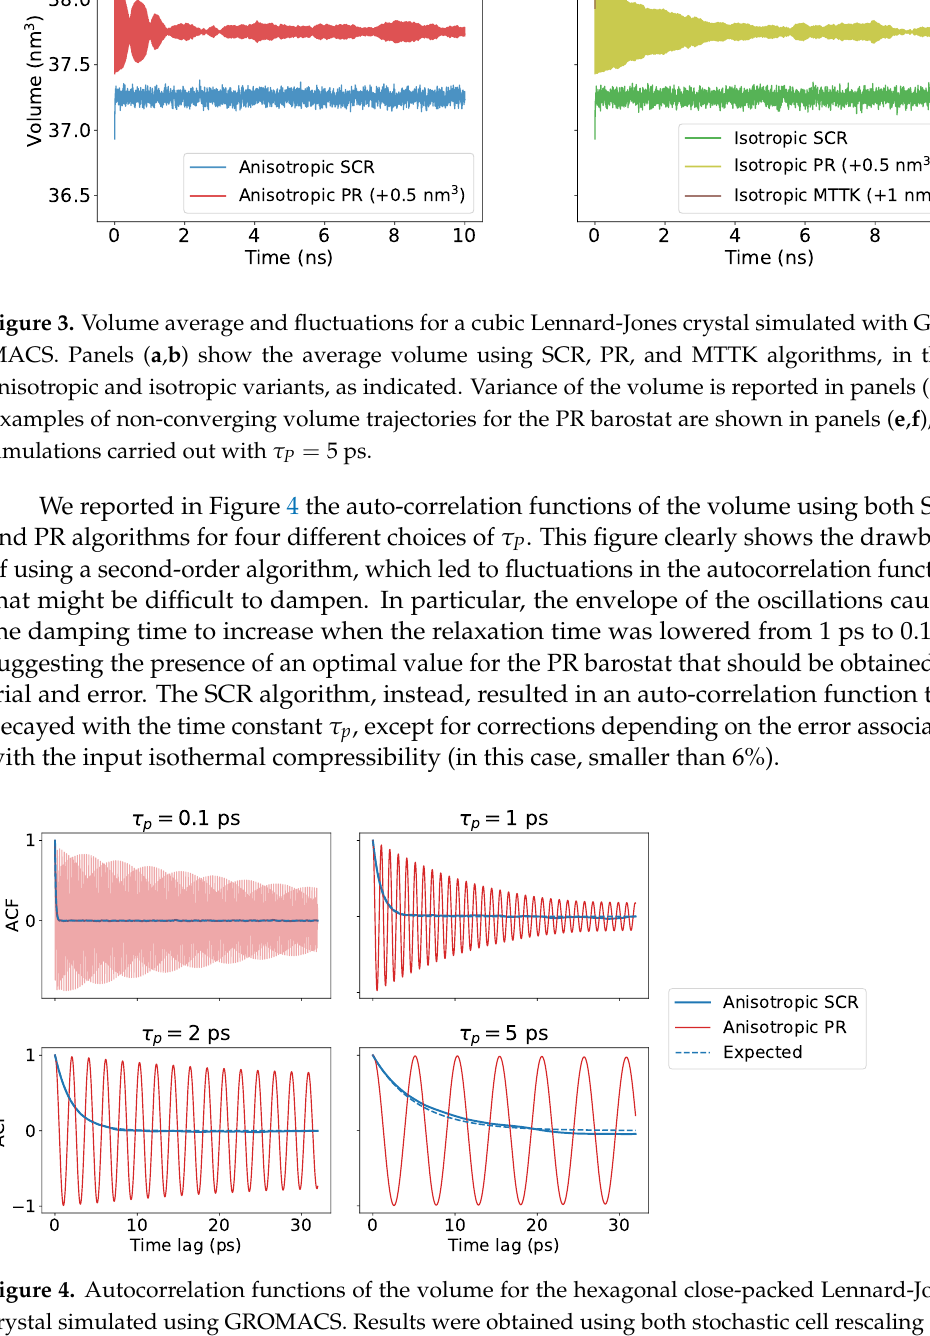
τ P , where β T ,exp β T